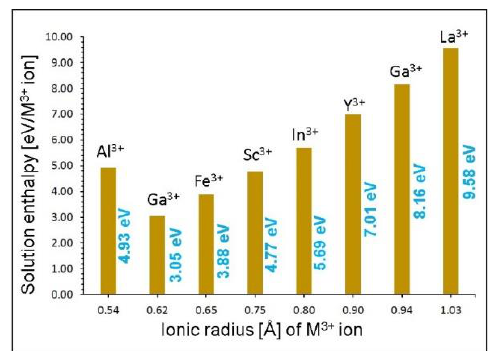
Figure 6. Enthalpy of solution of M 2 O 3 , (M = Al, Ga, Fe, Sc, In, Y, Ga and La) with respect to the M 3 +